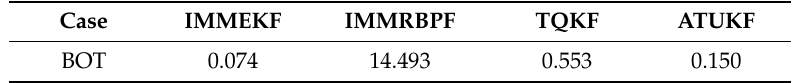
Table 2. Computation times for all algorithms (s). BOT: Bearings-only maneuvering tracking.